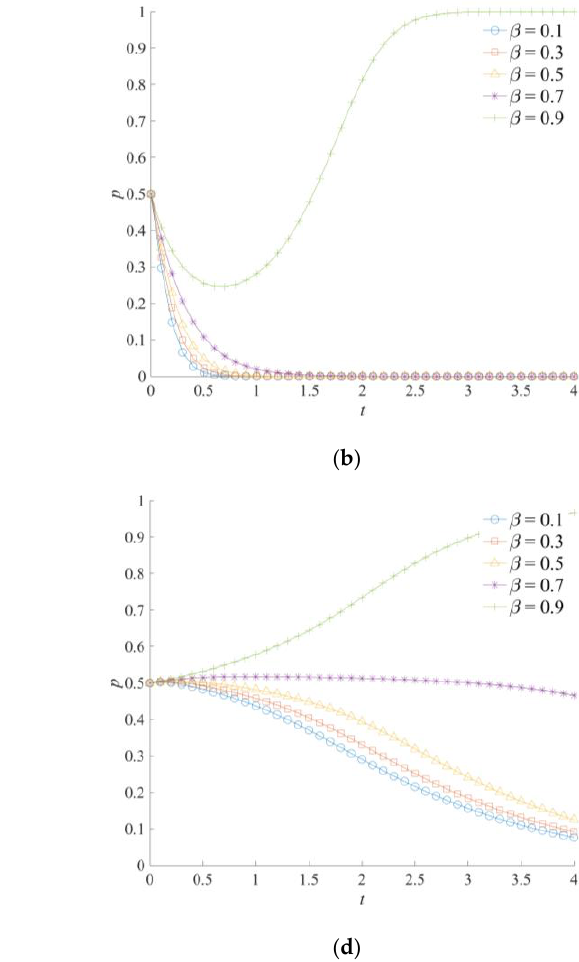
Figure 9. Evolution trajectory of the game system under different coverage effect coefficients of emergency capital: ( a ) The influence of β on the evolution of the game system; ( b ) the influence of β on the evolution of the local government; ( c ) the influence of β on the evolution of the neighboring government; ( d ) the influence of β on the evolution of the central government.